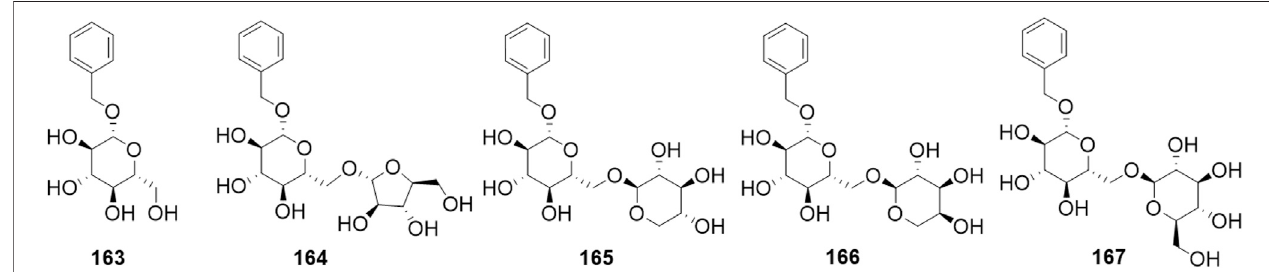
FIGURE 9 | Structures of the benzyl glycosides (163 – 167) form P. mume .